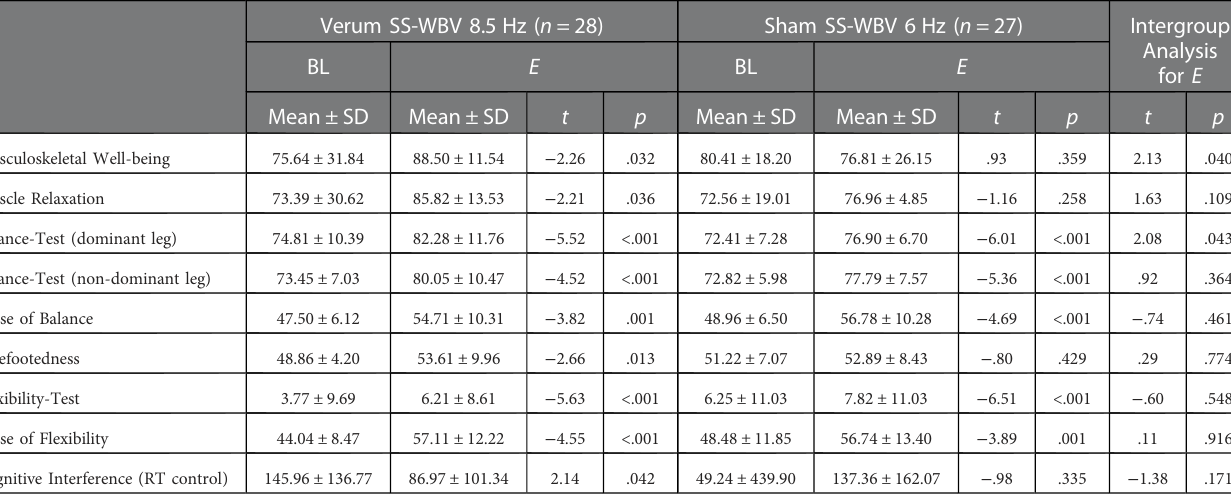
TABLE 2 Results of t -tests for each exercising